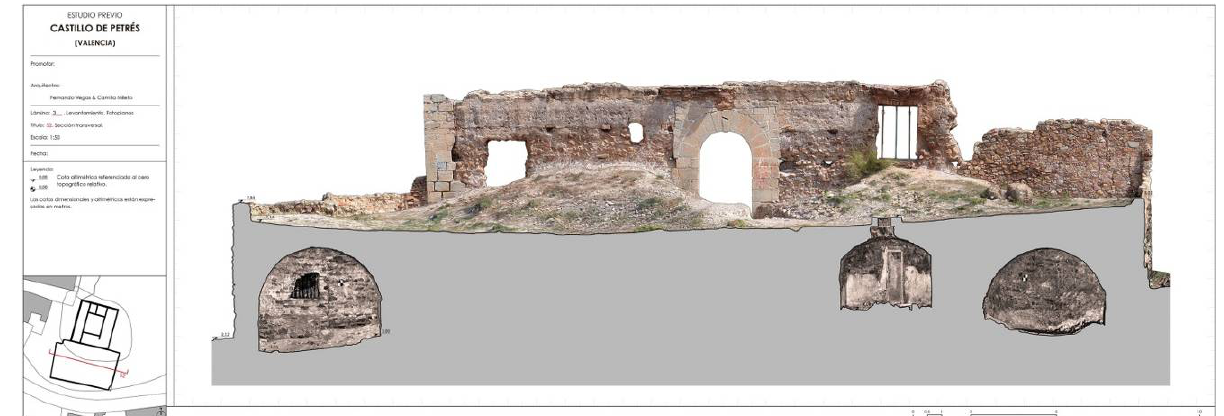
Fig. 6. Drone + scanner-lasser: Section of the Castle of Petrés (Valencia,